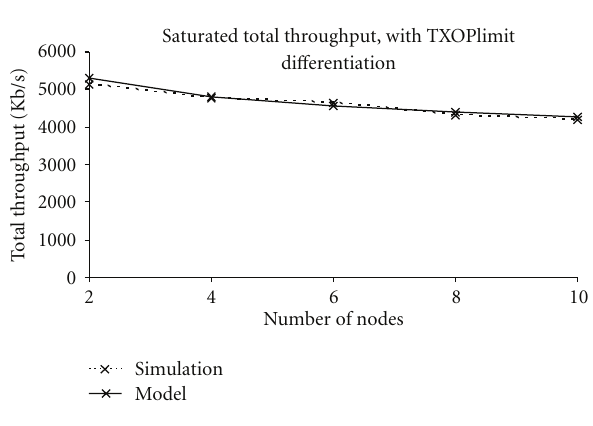
Figure 18: Total throughput, with TXOP.